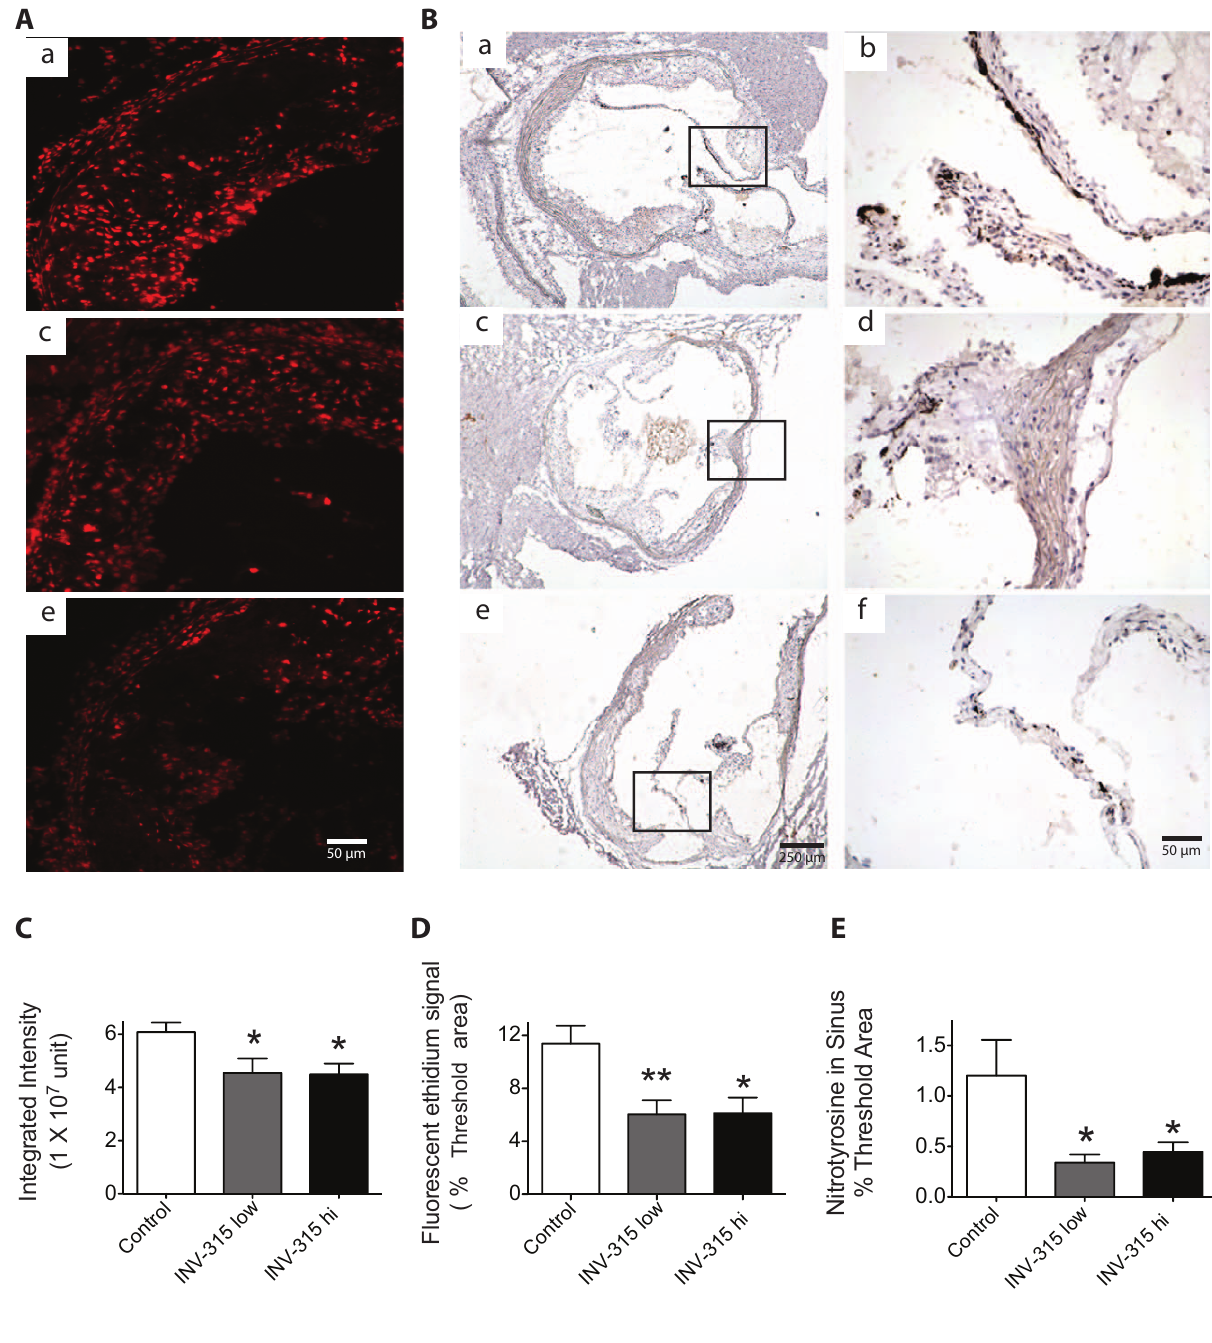
Figure 3. Effects of MPO inhibition on superoxide and nitrotyrosine within the mice sinus of HFD-fed mice. A. Fluorescent photomicrographs at identical settings of sections of sinus labeled with dihydroethidium [1] at 200 6 magnification. a, control mice treated with placebo; b, mice treated with INV-315 at low dose; c, mice treated with INV-315 at high dose. B, Representative images of immunohistochemistry for nitrotyrosine in the sinus. a and b, control mice treated with placebo; c and d, mice treated with INV-315 at low dose; e and f, mice treated with INV- 315 at high dose. b, d and f in the right panel are higher magnifications of a, c and e in the left panel respectively. C and D. Quantification of the fluorescent ethidium signal in the sinus by integrated intensity (C) and % threshold area (D). E. Statistical analysis of immunohistochemistry for nitrotyrosine in the sinus. * P , 0.05, ** P , 0.01 compared with control group. Data are mean 6 S.E.M. of 7–9 experiments from different mice.